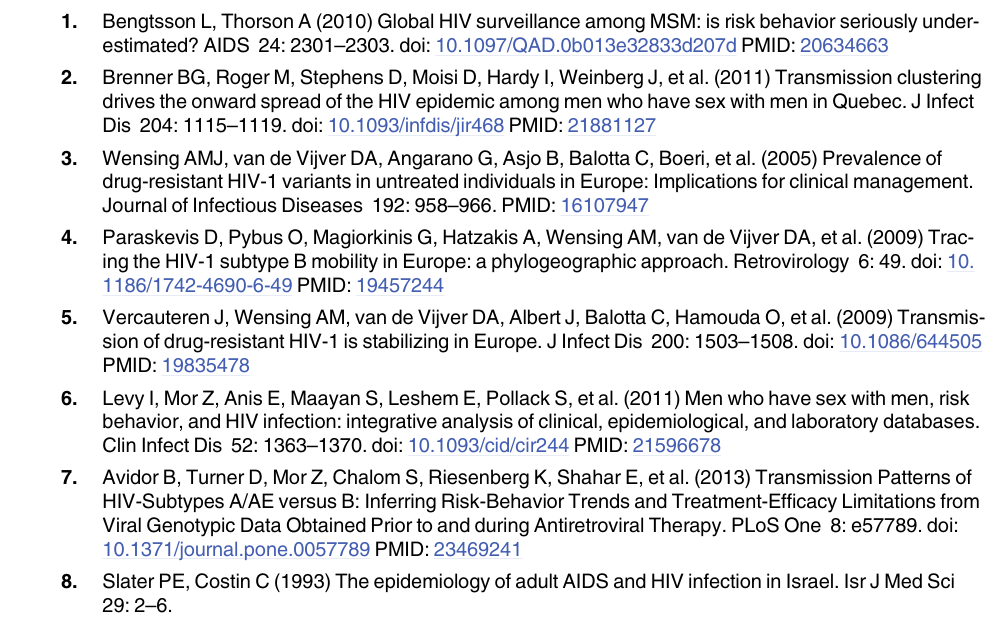
S2 Table. Resistance related mutations. Accessory mutations and polymorphisms listed by